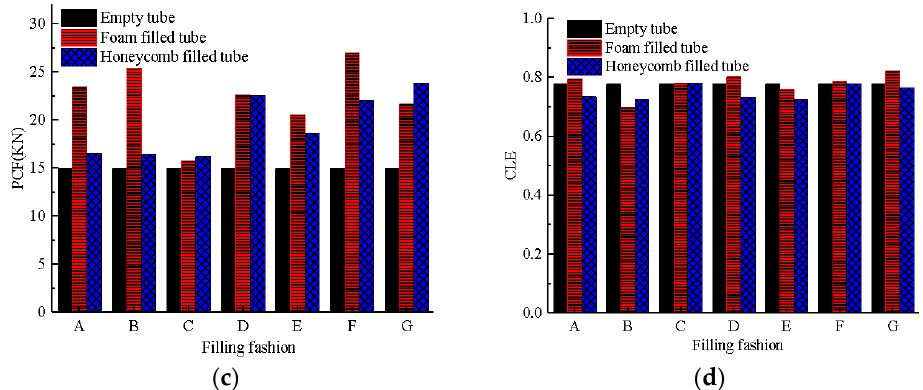
Figure 8. The performance indicatorsof the filling structures under different filling methods: ( a ) EA ; ( b ) SEA ; ( c ) PCF ; ( d ) CLE .